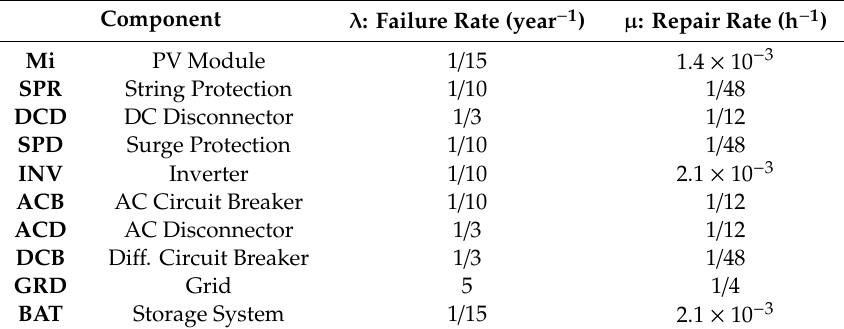
Table 5. Failure/repair rates and of the photovoltaic power plant. Table 5. Failure / repair rates and of the photovoltaic power